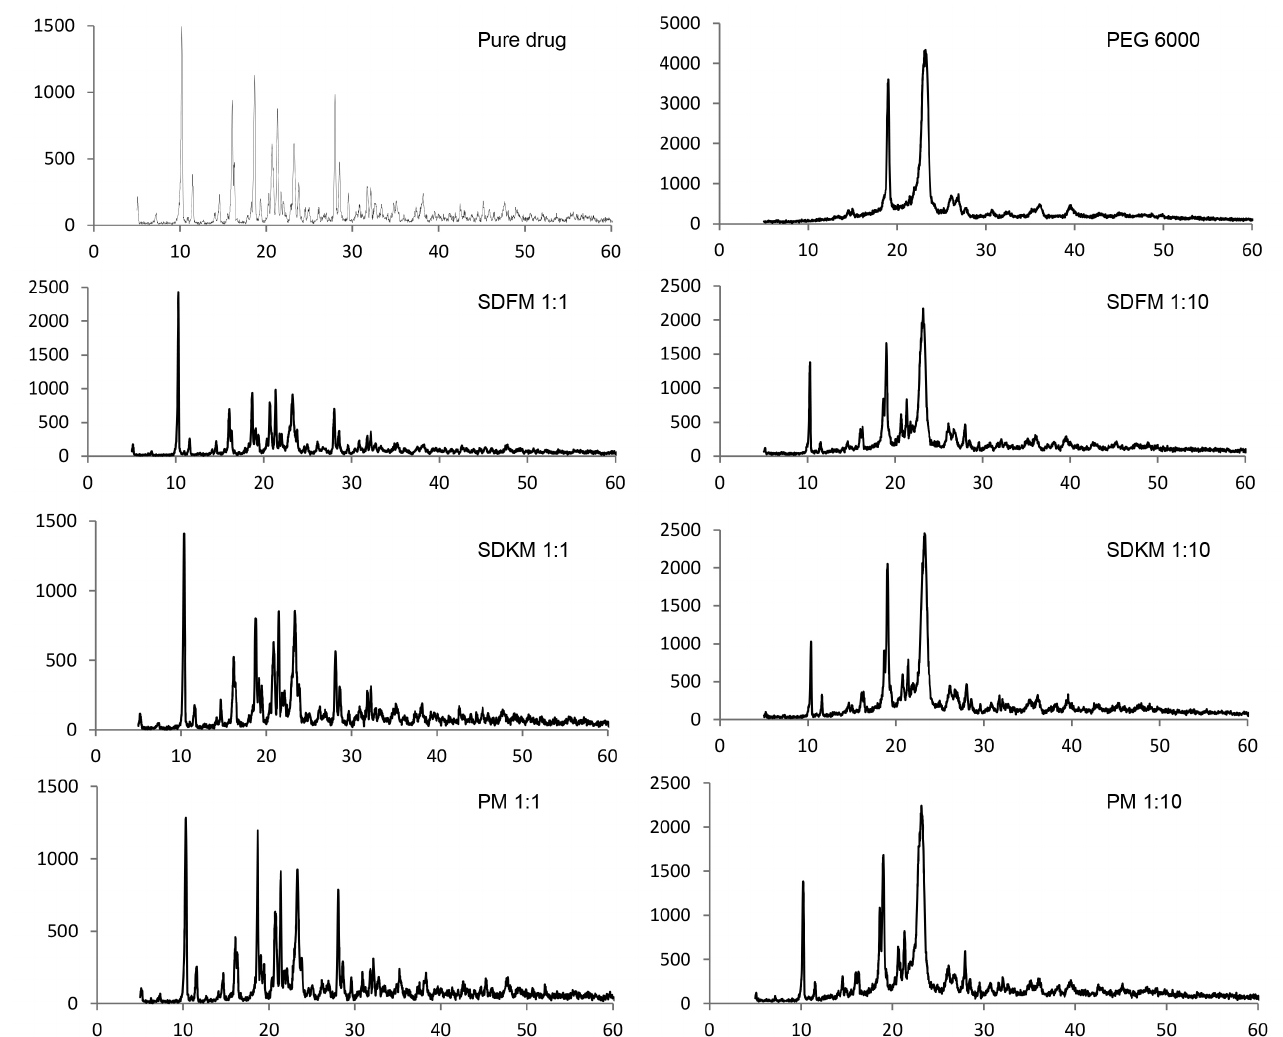
FIGURE 3 - X-ray diffraction patterns of AMH, physical mixture and solid